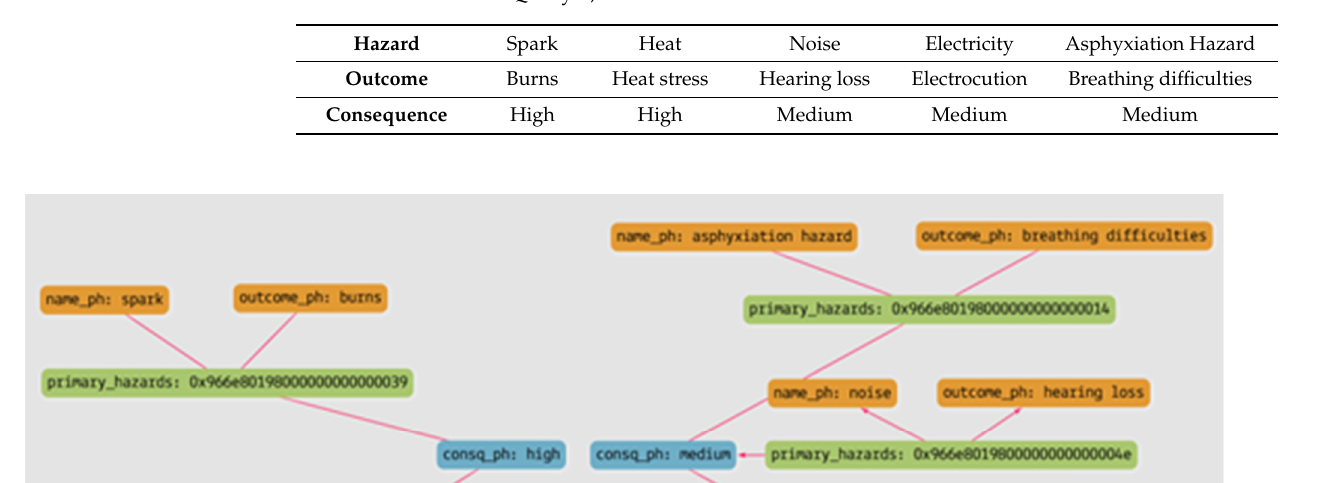
Table 5. The result of Query 1, in a tabular form.